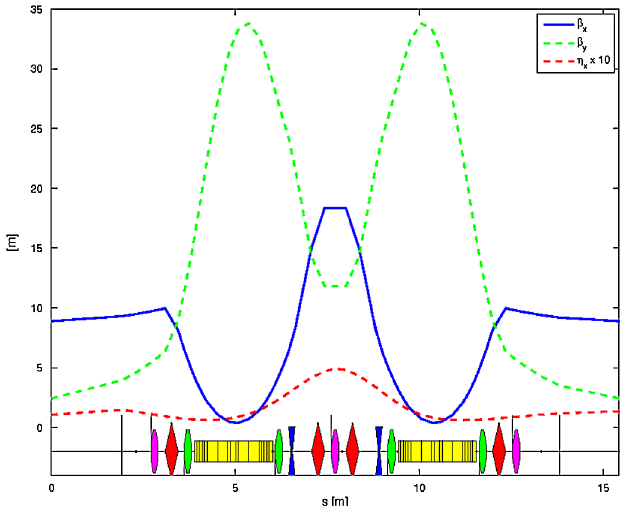
FIG. 1. Storage ring magnets and lattice functions. Dipoles (yellow), quadrupoles (red/blue), and sextupoles (green/purple) are shown. Skew quadrupoles are located in the 2nd and 6th sextupole. Betatron tunes are (cid:3)